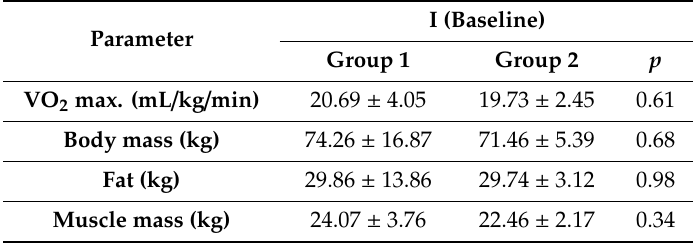
Table 1. Anthropometric characteristics of participants at baseline (n =